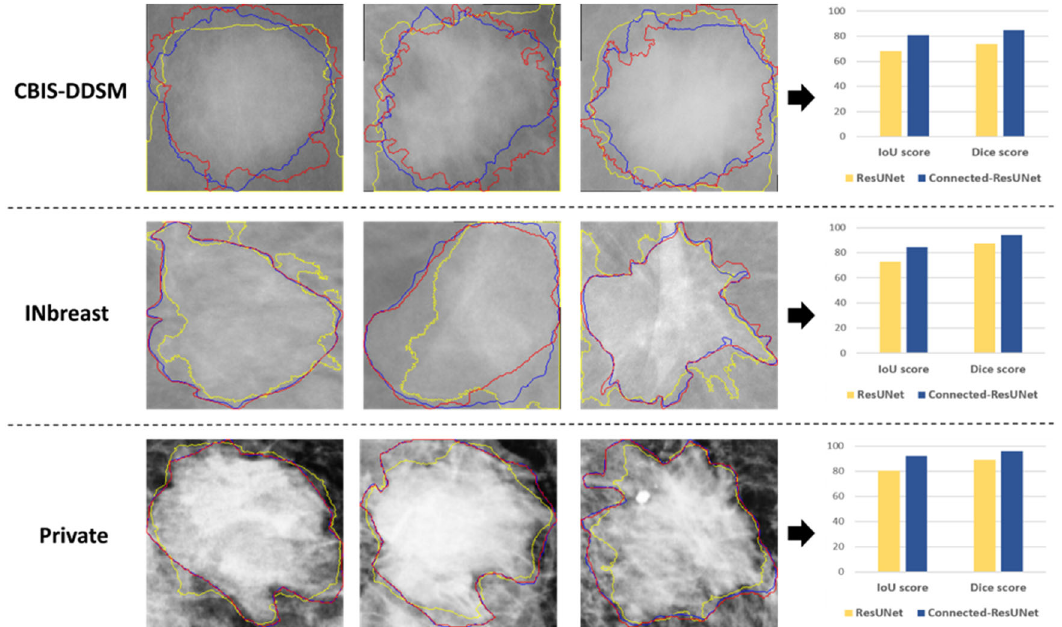
Fig. 5 Examples of the segmented masses for the proposed architecture Connected-ResUNets comparing with the ResUNet. Top row shows three examples of mammograms from the CBIS-DDSM dataset. Middle row shows three examples of mammograms from the INbreast dataset. Bottom row shows three examples of mammograms from the private dataset. Each example indicate contours of their ground-truth images, contours of segmentation output images of the standard ResUNet, and contours of segmentation output images of the proposed Connected-ResUNets. Each row also include a comparative bar chart of IoU score and Dice score of ResUNet and Connected-ResUNets models.